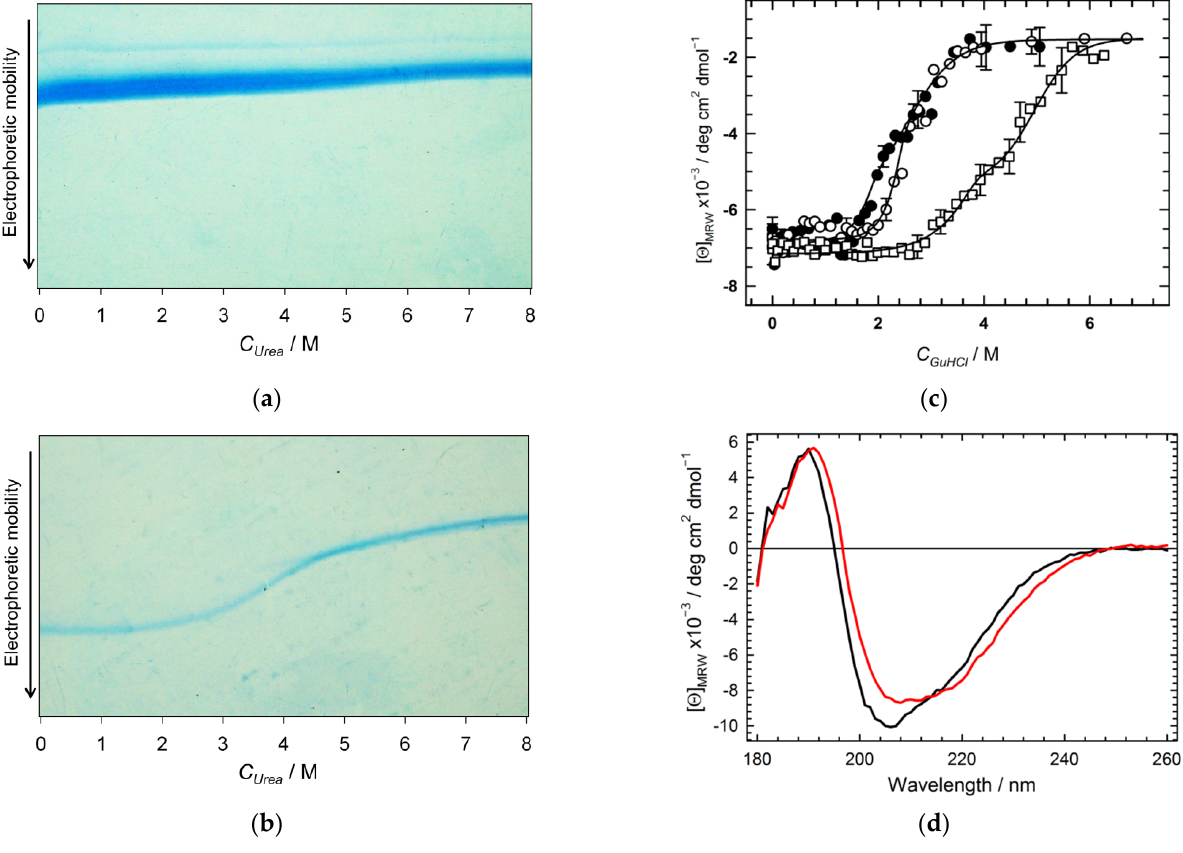
Figure 3. The effect of urea on Hfq structure ( a , b ), GuHCl ( c ), and temperature ( d ): ( a ) Transverse urea gradient gel electrophoresis of the Hfq Y55W hexamer; ( b ) Transverse urea gradient gel electrophoresis of the Hfq Y55W/D9A/V43R monomer; ( c ) The CD-monitored GuHCl-induced unfolding of the Hfq Y55W (circles) at 66 μ M (open symbols) and 6 μ M (filled symbols), and Hfq WT (squares) at 66 μ M. The error bars correspond to the deviations from average values as a result of five measurements. The solid lines stand for the best fittings of the data with the parameters shown in Table 2; ( d ) The CD spectra of monomeric triple Hfq mutant at 20 °C (black line) and at 90 °C (red line) at a protein concentration of 1.24 mg/mL (124 μ M of monomers). Table 2. The thermodynamic parameters of Hfq equilibrium unfolding transitions (as shown by the linear extrapolation method (LEM) [20,21]).